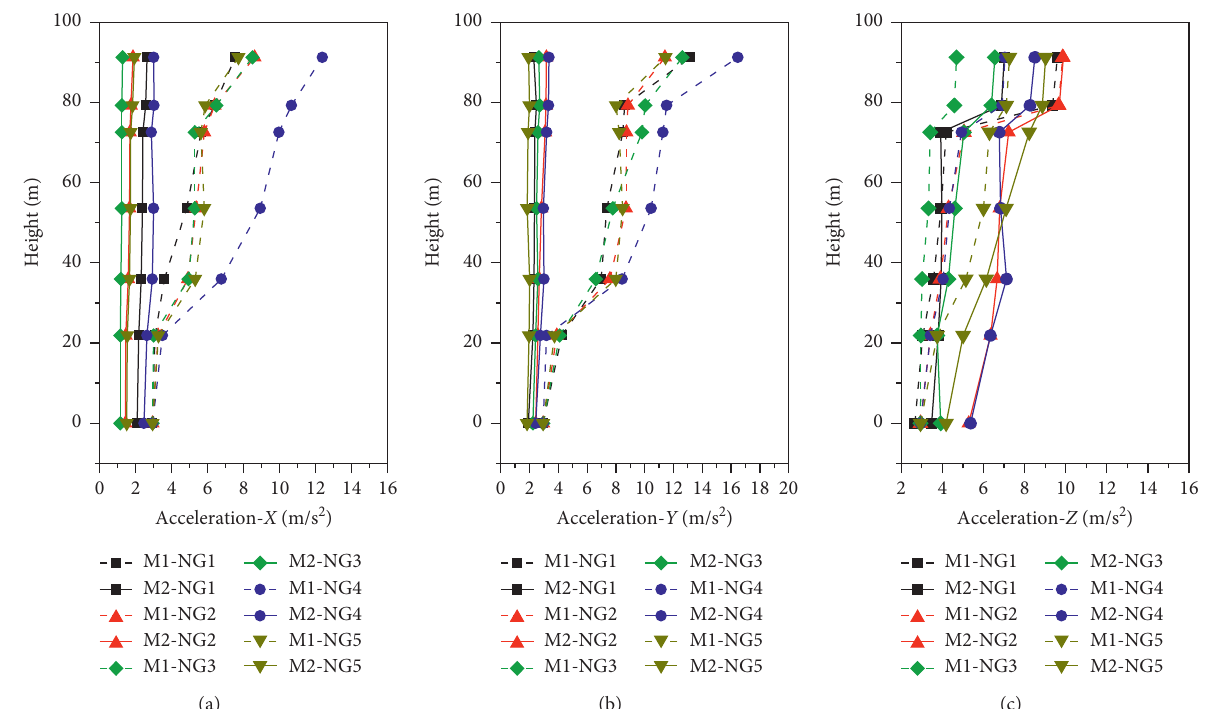
Figure 13: Comparison of peak acceleration along the height of structure under NG1-NG5. Note. M1 and M2 are the mean of model one and model two. (a) X -direction, (b) Y -direction, and (c) Z -direction.